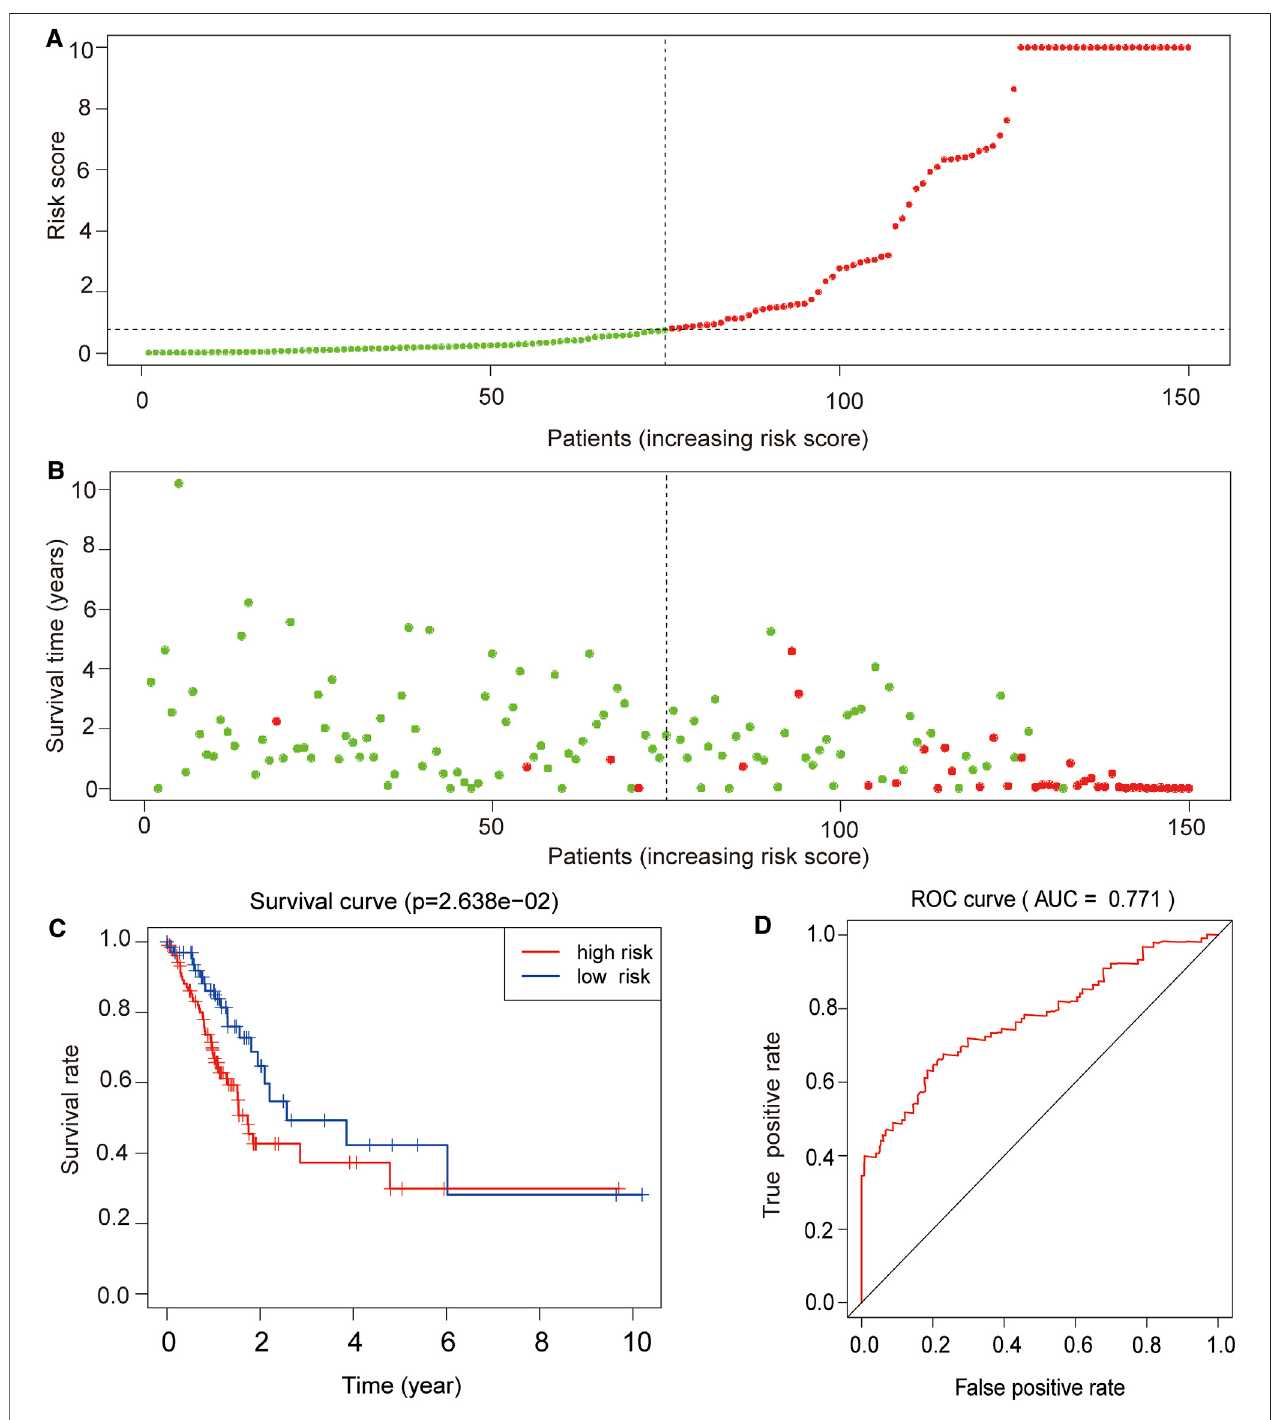
FIGURE 7 | External validation of the prognostic value of the four lncRNA signatures. (A) Risk curve and ( B) survival status chart of the validation dataset based on the proposed prognostic model. Each dot represents an individual patient, and the y -axis indicates the respective riskscore. Green and red colors indicate the low- and high-risk groups, respectively. (C) Kaplan – Meier survival and (D) receiver operating characteristic (ROC) curves of the validation dataset based on the proposed prognostic model. The x -axis represents the overall survival time in years, and the y -axis indicates the survival rate of the patients according to their de fi ned risk group. p -values were calculated by the log-rank test. Analysis of the area under the ROC curve (AUC (cid:1) 0.771) indicated that the proposed model had a good risk prediction potential.